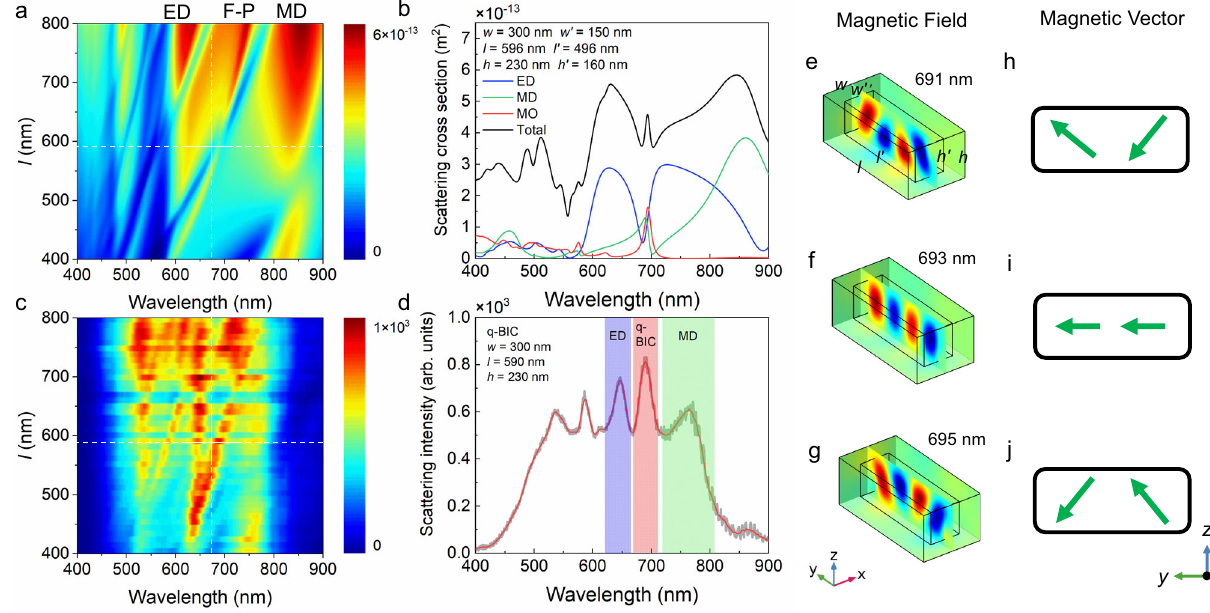
Fig. 2 Scattering properties of Si/SiO 2 cuboids and the magnetic fi eld distribution at the quasi-BIC. a Scattering spectra calculated for Si/SiO 2 cuboids with variable length l and fi xed width w = 300 nm and height h = 230 nm, the thicknesses of the outer SiO 2 layer in the x, y, z directions are chosen to be t x = 75 nm, t y = 50 nm, and t z = 70 nm. b Scattering spectrum calculated for the Si/SiO l = 596 nm, w = 300 nm and h = 230 nm, which has 2 cuboid with been decomposed into the contributions of the Mie resonances of different orders. c Scattering spectra measured for Si/SiO 2 cuboids with the same width of w ~ 300 nm and different lengths. The length of the Si/SiO 2 cuboid supporting the quasi-BIC is indicated by the dashed line. d Scattering spectrum measured for a Si/SiO 2 cuboid with l ~ 590 nm and w ~ 300 nm. The scattering peaks corresponding to the ED, quasi-BIC, and MD resonances are marked by colored regions. e – g , Magnetic fi eld distributions calculated for the Si/SiO 2 cuboid with l = 596 nm and w = 300 nm at different wavelengths of 691, 693, and 695 nm. The magnetic vectors corresponding to the magnetic fi eld distributions are shown in h – j . Here, ED, F-P, MD, MO represent electric dipole, Fabry-Perot mode, magnetic dipole, and magnetic octupole,